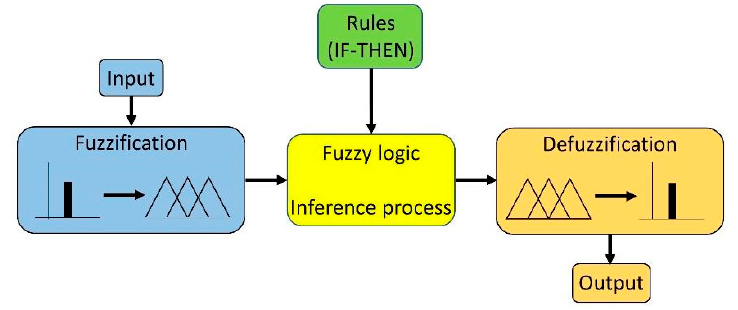
Figure 17. The typical structure of an FL system.